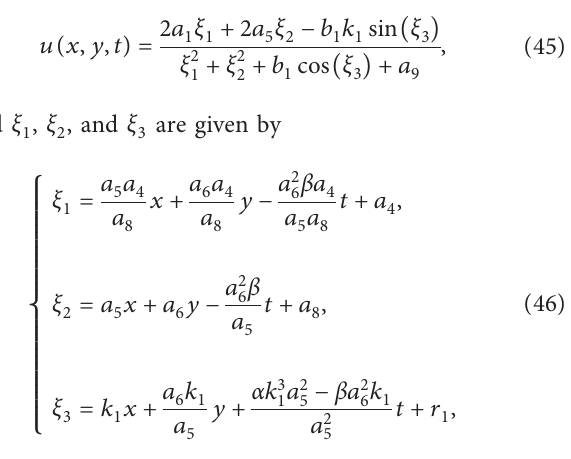
� 1, a � 1, p � 1, k � 1, α � 1, β � 1 5 1 1